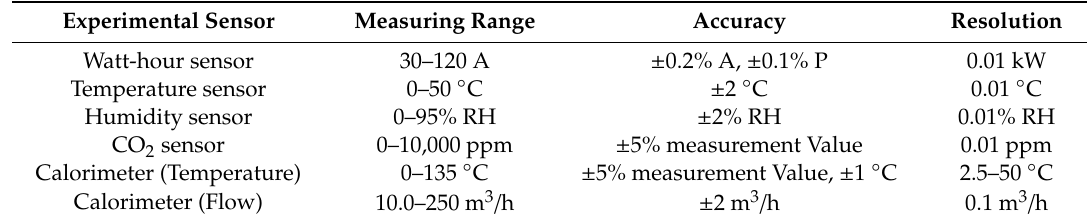
Table 5. Information on each sensor.